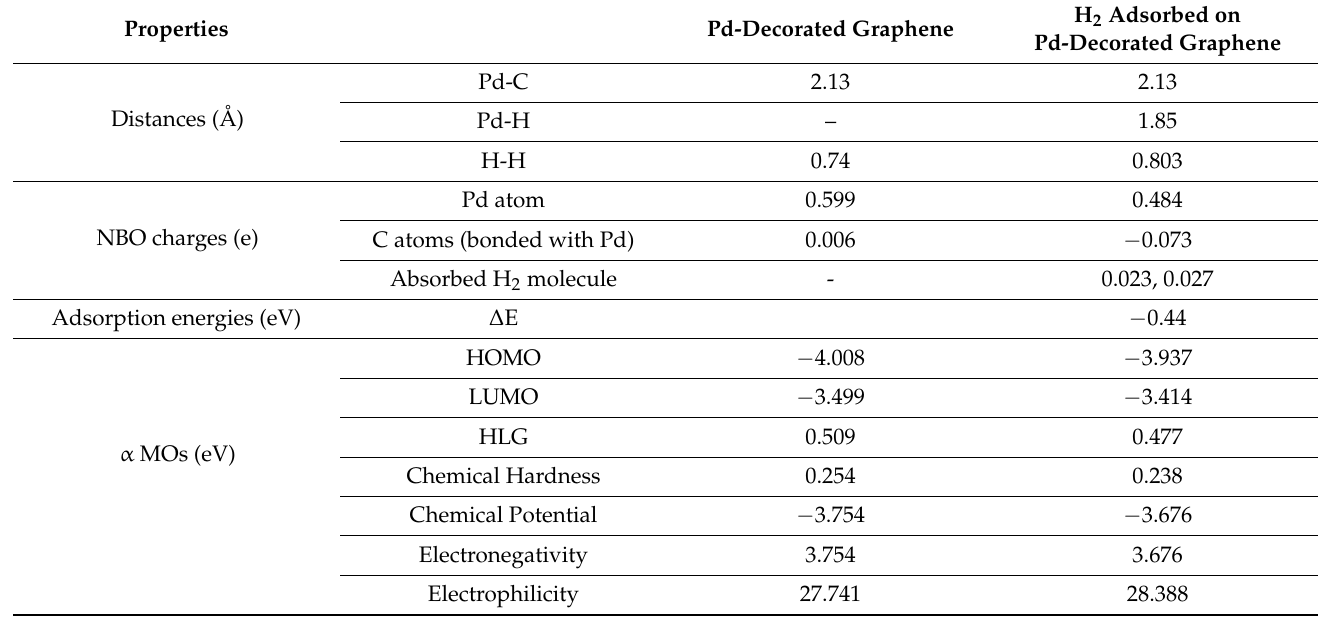
Table 2. Properties of the Pd-decorated graphene cluster before and after H 2